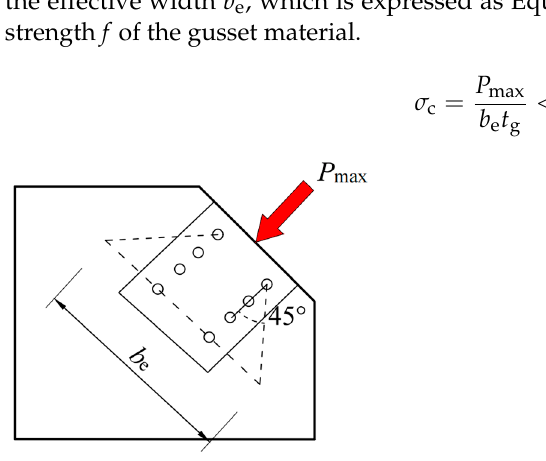
Figure 3. GUFM [24].